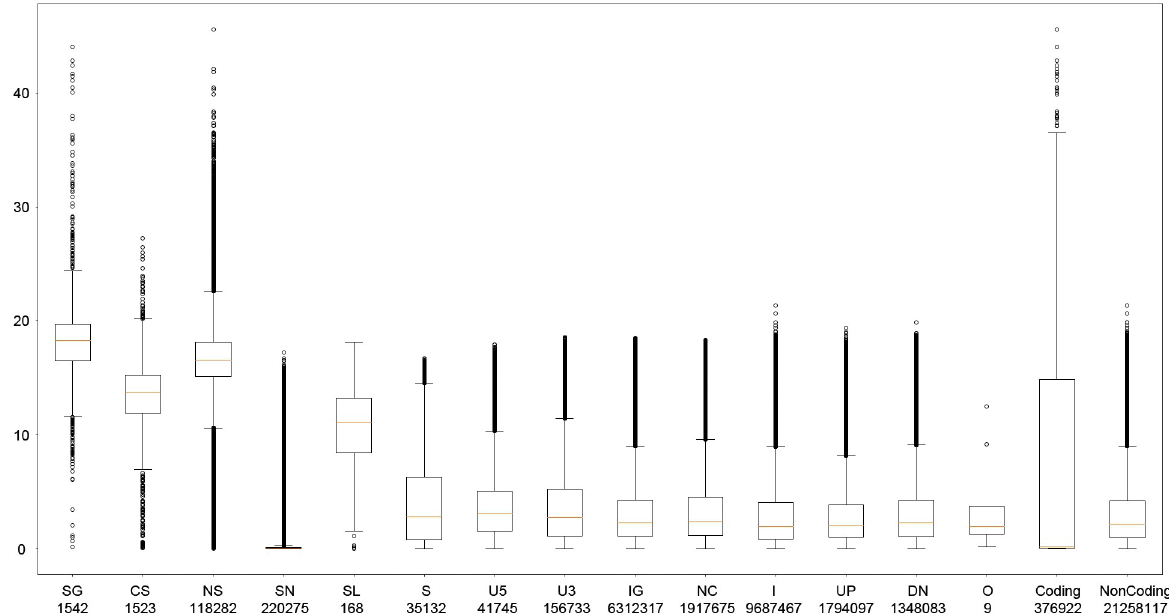
Fig 3. chCADD score distribution of SNPs per Variant Effect Predictor (VEP) cateogy. SNPs from the 169 chickens are categorized based on the VEP categories reported in S2 Table. In addition, we joined them based on if they are located within a coding or non-coding region. Abbreviations: SG: Stop-Gained; CS: Canonical Splice; NS: Non-Synonymous; SN: Synonymous; SL: Stop-Lost; S: Splice Site; U5: 5’-UTR; U3: 3’- UTR; IG: Intergenic; NC: Noncoding-Change; I: Intronic; UP: Upstream; DN: Downstream; O: Other. Coding: the joined set of CS, NS, S, SG, SL, SN; NonCoding: DN, I, IG, NC, U3, U5, UP. The label indicates the category and the number of SNPs falling into that